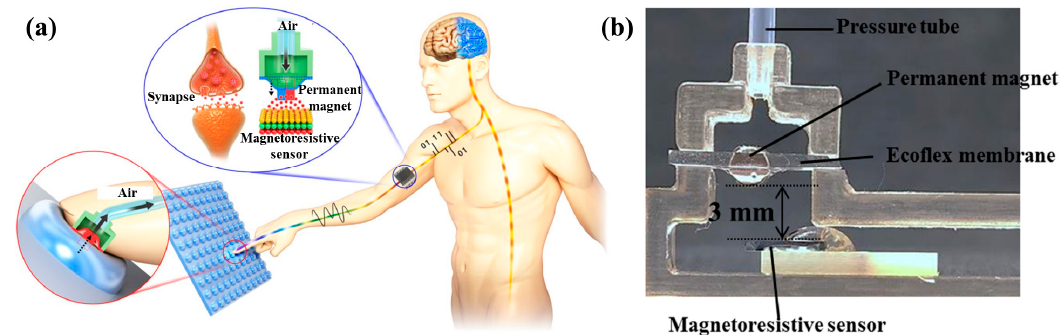
Figure 15. ( a ) Schematic illustration of remote tactile sensing system with magnetic synapse inspired by human tactile sensing and synaptic transmitter. Reprinted with permission from Ref. [63]. Copyright 2017, Springer Nature; ( b ) Cross-sectional image of magnetic synapse with air tube connected. Reprinted with permission from Ref. [63]. Copyright 2017, Springer Nature.